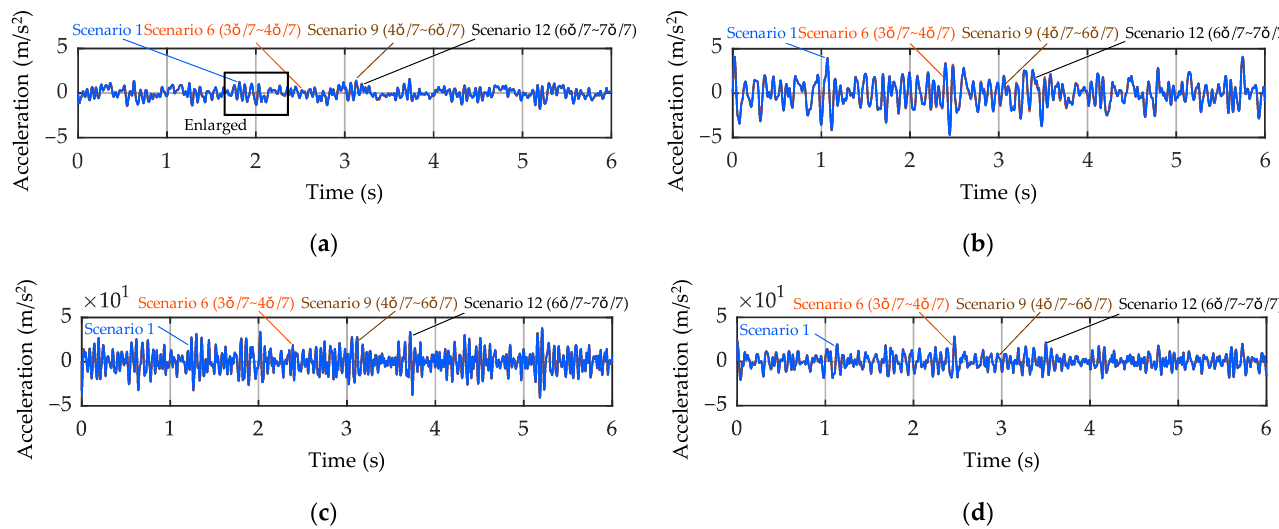
Figure 6. The vehicle vibration accelerations for each case: Scenario 1, Scenario 6, Scenario 9, and Scenario 12: ( a ): 𝑧̈ 𝑠1 ; ( b ) 𝑧̈ 𝑠2 ; ( c ) 𝑧̈ 𝑢1 ; and ( d ) 𝑧̈ 𝑢2 . Table 5. The natural frequencies of the vehicle and bridge (Unit: Hz).